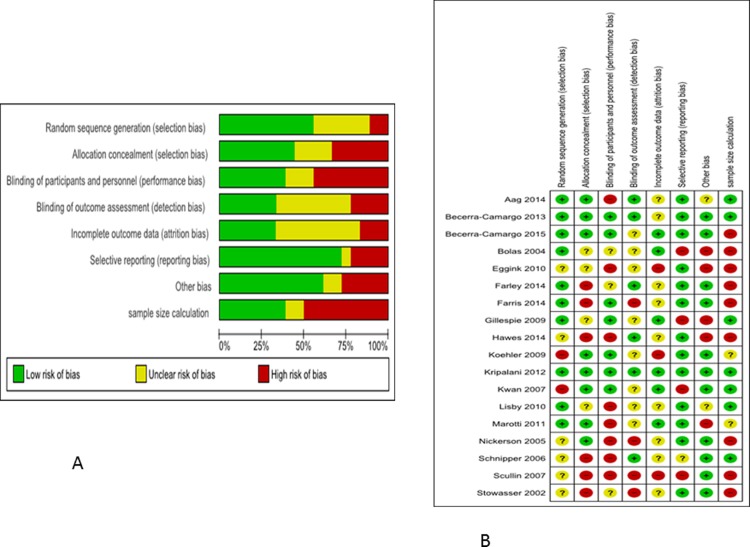
(a) Risk of bias graph: review authors' judgements about each risk of bias item presented as percentages across all included studies. 2 (b) Risk of bias summary: review authors' judgements about each risk of bias item for each included study.